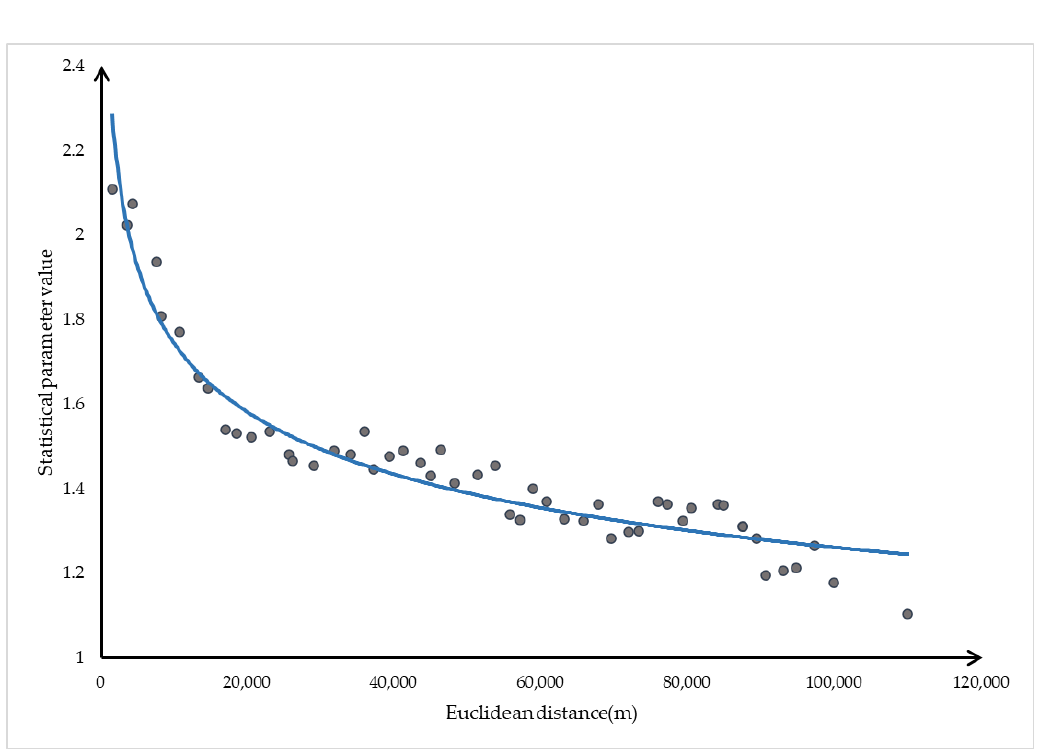
Figure 2. Curve fitting of sample elements in SE.